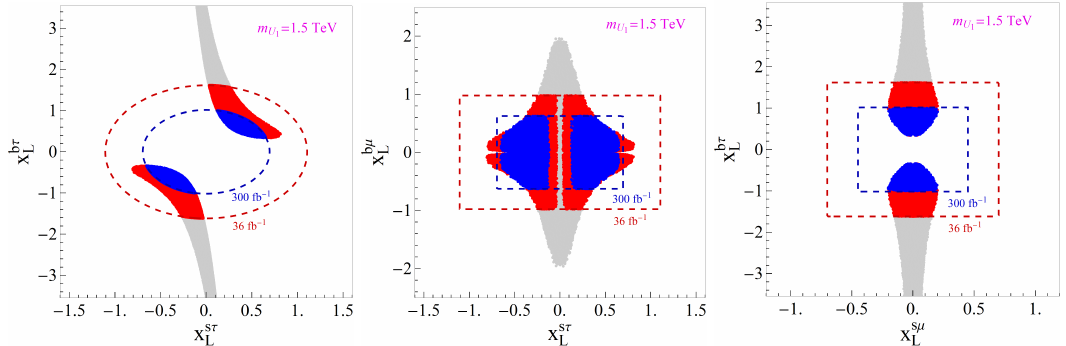
Figure 5: Scatter plots showing the allowed regions of parameter space for different combination of U LQ couplings assuming m 1 text.